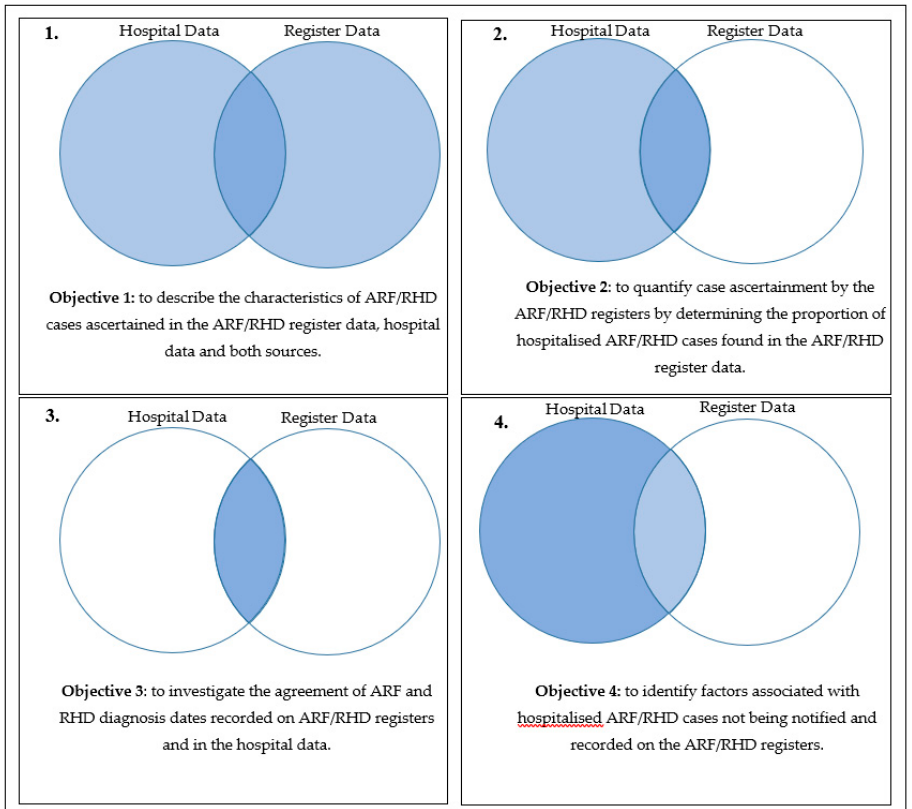
Figure 1. Study objectives and sub-samples.